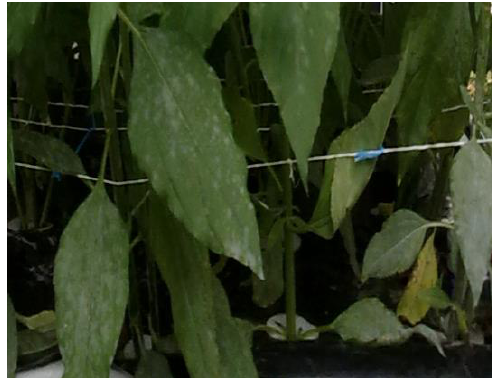
Figure 5. Jerusalem artichoke affected by powdery mildew.